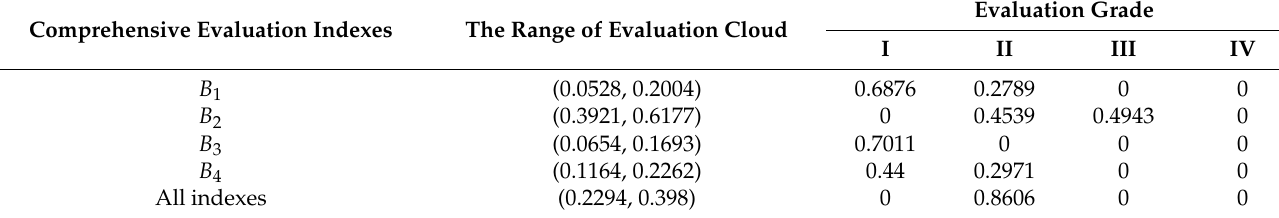
Figure 7. Cloud picture of comprehensive risk evaluation of all indexes. Table 12. The similarity between the roof risk assessment cloud pictures and the standard cloud pictures. Comprehensive Evaluation Indexes